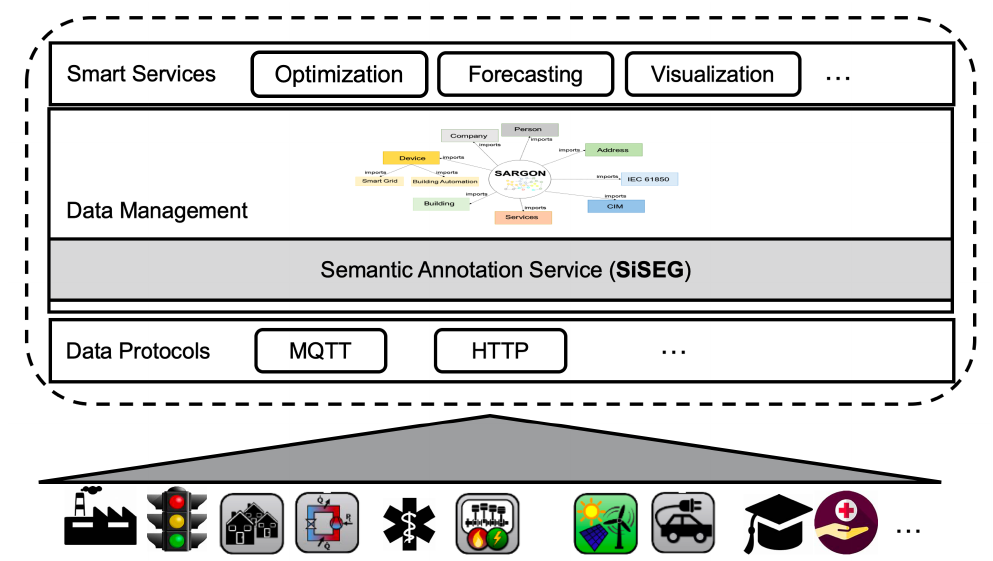
Figure 1. Semantic as a service in the smart system